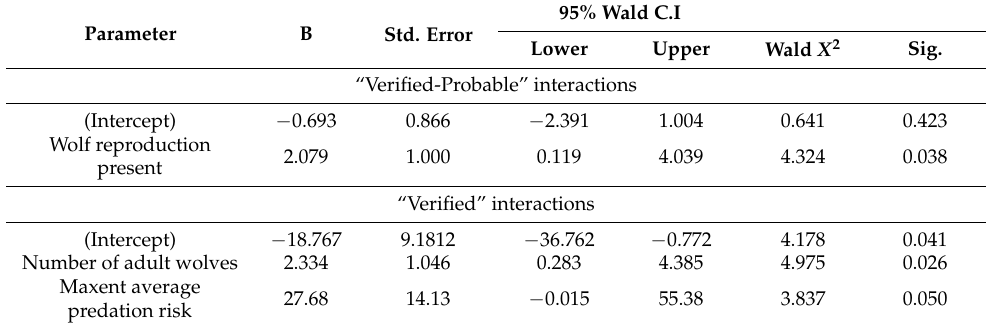
Table 5. Factors related to the number of attacks per wolf social unit located in the study area for the year 2019–2020 for the following: (a) the “verified-probable” (GLM with negative binomial link function, likelihood ratio Chi-square = 4.693, p = 0.030, AICc = 38.658), and (b) the “verified” data sets (GLM with Poison log link, X 2 likelihood ratio test = 17.420, p < 0.0001, AICc =